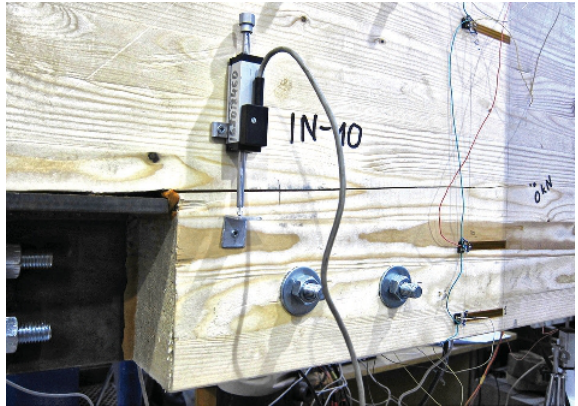
Fig. 11. Longitudinal technological cracks in timber